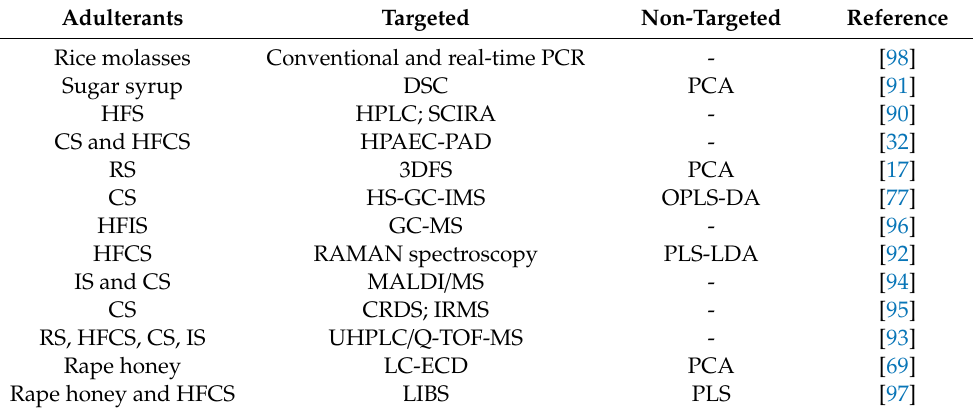
Table 4. Summary of analytical approaches of articles related to the honey adulteration with